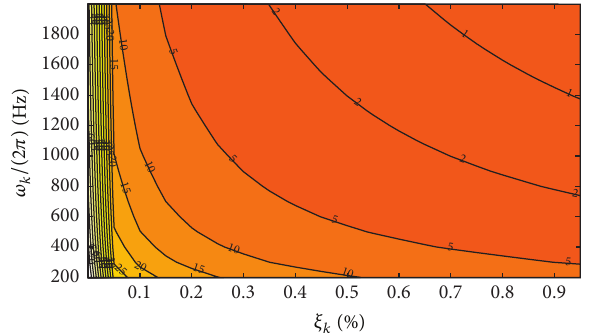
Figure 18: Perf |𝑇 𝑧𝑤 | max as function of 𝜉 𝑘 and 𝜔 𝑘 for 𝜓 2 𝑘 𝛾 Table 4).